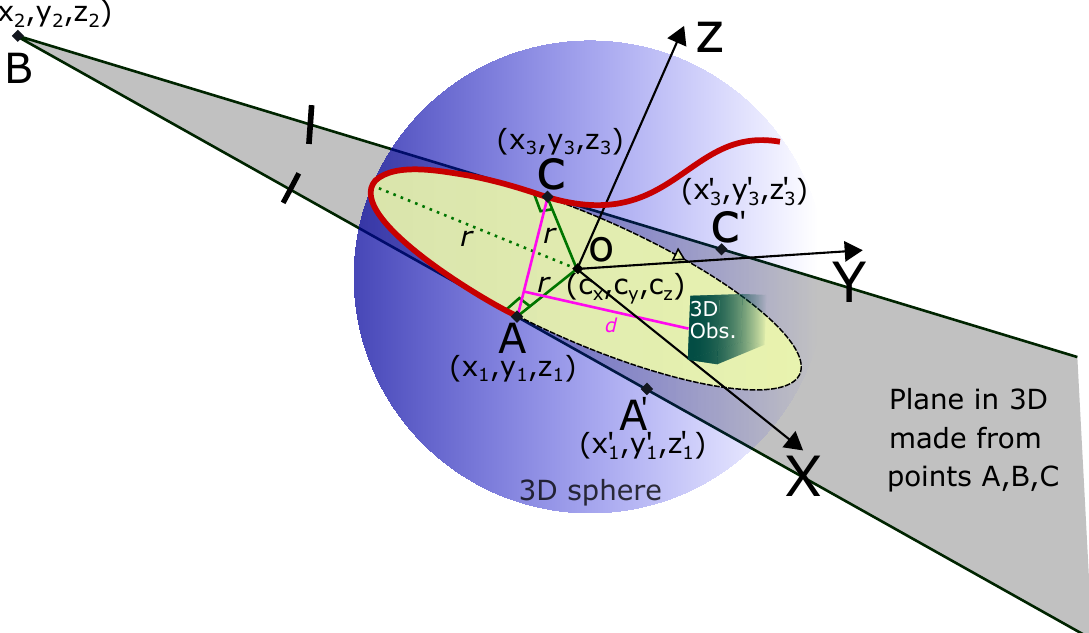
Figure 6. 3D path smoothing with ITC. The points A,B, and C are in 3D space. The intersection of the 3D sphere and the plane generated from the three points marks the arc to smooth the